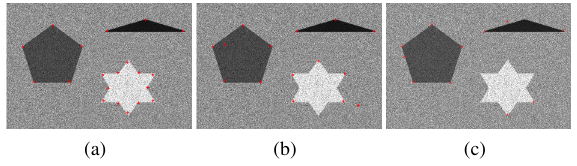
Figure 4. The detection results of three detectors on the simulated SAR image. (a) Proposed. (b) SAR-FAST. (c) SAR-Harris.